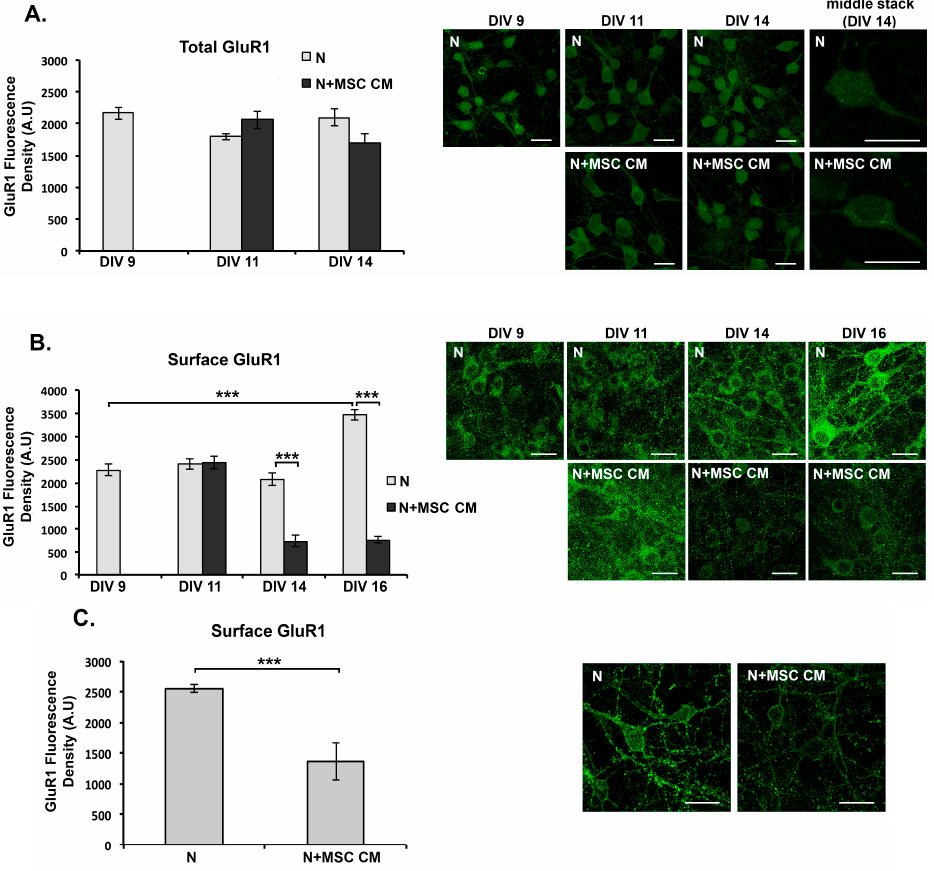
Figure 5. MSC secreted factors reduce neuronal cell surface, but not total, levels of the GluR1 α -amino-3-hydroxy-5-methyl-4-isoxazolepropionic acid receptor (AMPAR) subunit in mouse cortical neuron (N) cultures. DIV 9 neurons were grown in MSC CM for different lengths of time, fixed and immunostained using anti-GluR1-NT antibody. ( A ) Total neuronal levels of GluR1 (surface and intracellular) were measured in fixed, Triton X-100-permeabilized neurons after different times of culture with MSC CM or control medium. ( B ) Cell surface levels of GluR1 were measured in paraformaldehyde/sucrose fixed neurons after different times of culture with MSC CM or control medium. ( C ) Cell surface levels of GluR1 were measured in live neurons by immunostaining with anti-GluR1-NT antibody after 24 h culture with MSC CM or control medium (DIV 9) prior to fixation. Representative fields from each culture are shown in photographs including individual stacks from DIV 14 neurons showing differential localization of GluR1 in untreated and MSC CM-treated neurons ( A ). Scale bars 20 µ M. Results shown are means ± SEM of triplicate samples from one representative of three independent experiments. *** p < 0.001 for indicated pairwise comparisons by Student’s t